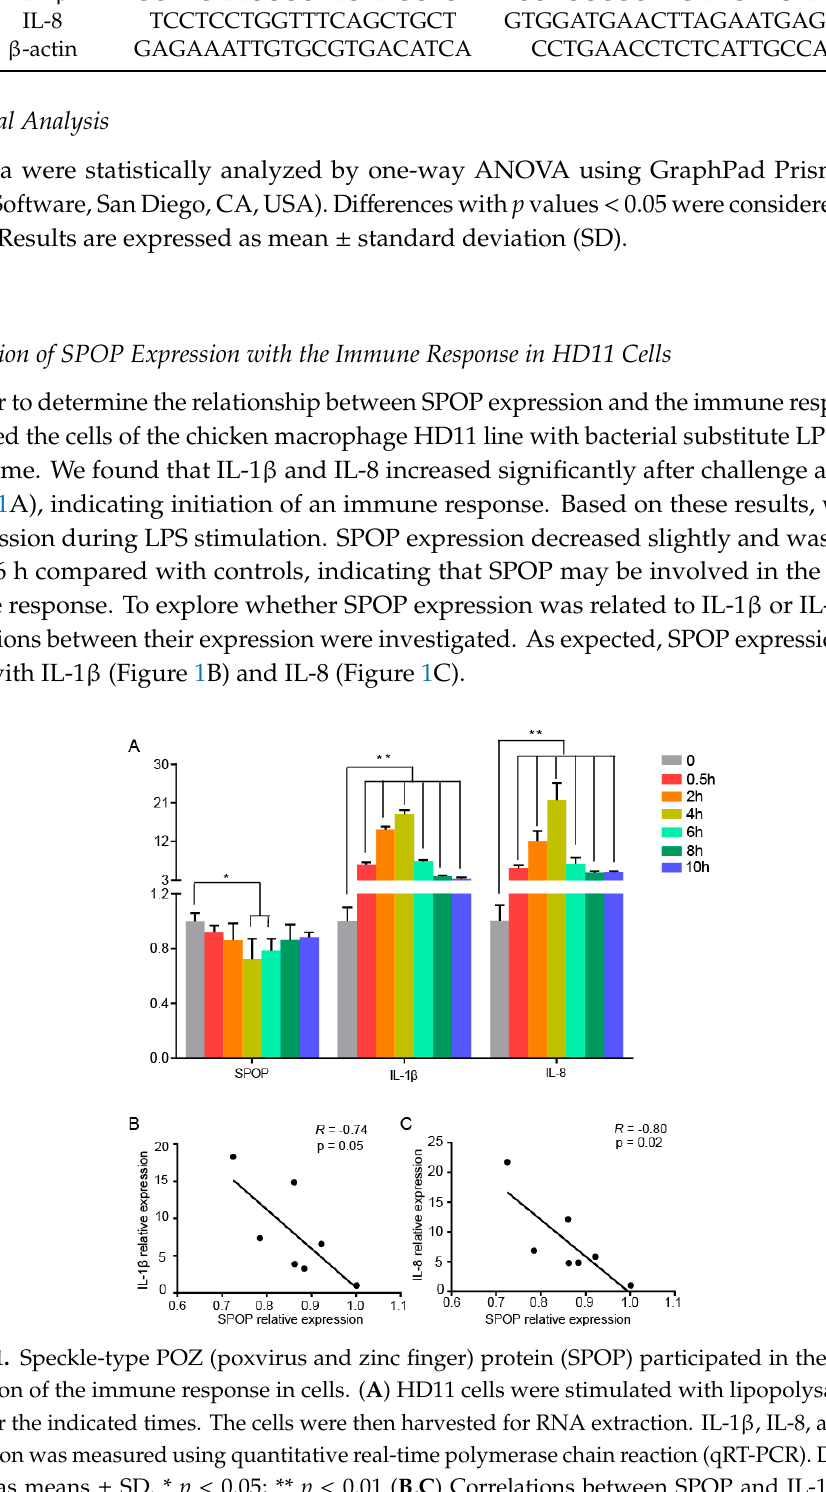
Table 1. Primers used for quantitative real-time polymerase chain reaction (qRT-PCR).